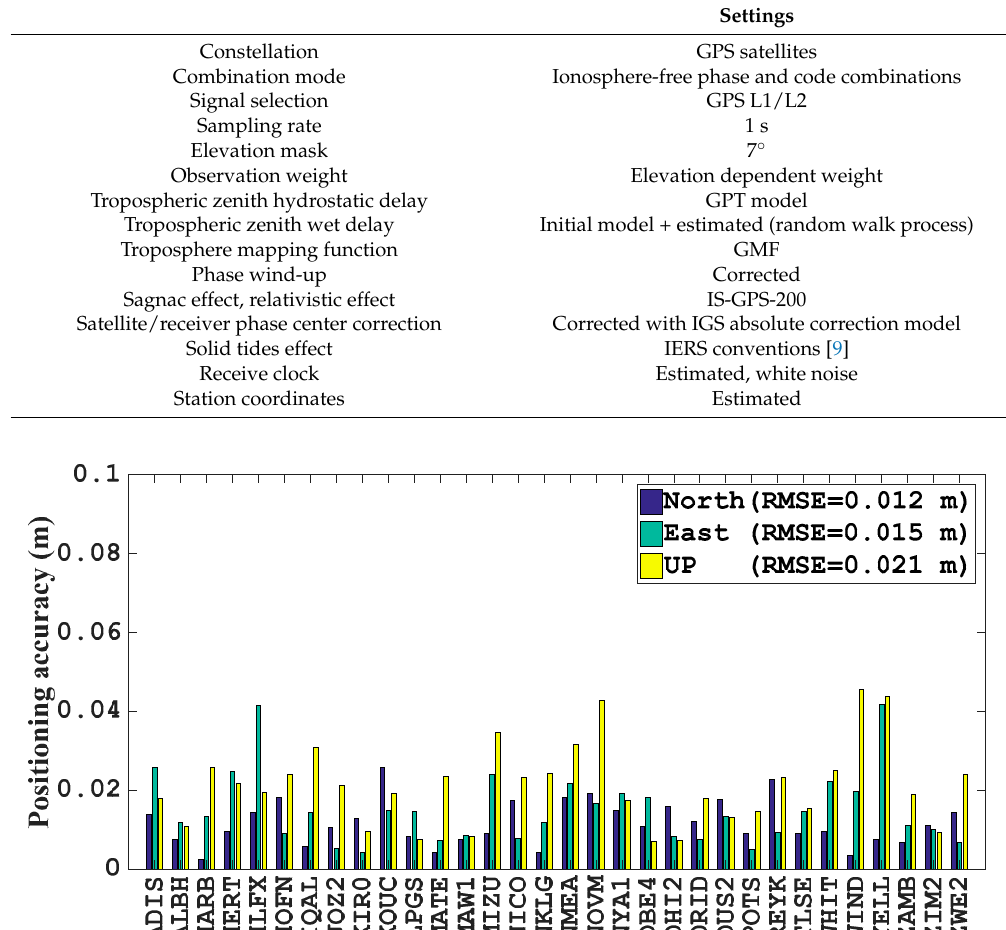
Table 4. Filter settings for the PPP.